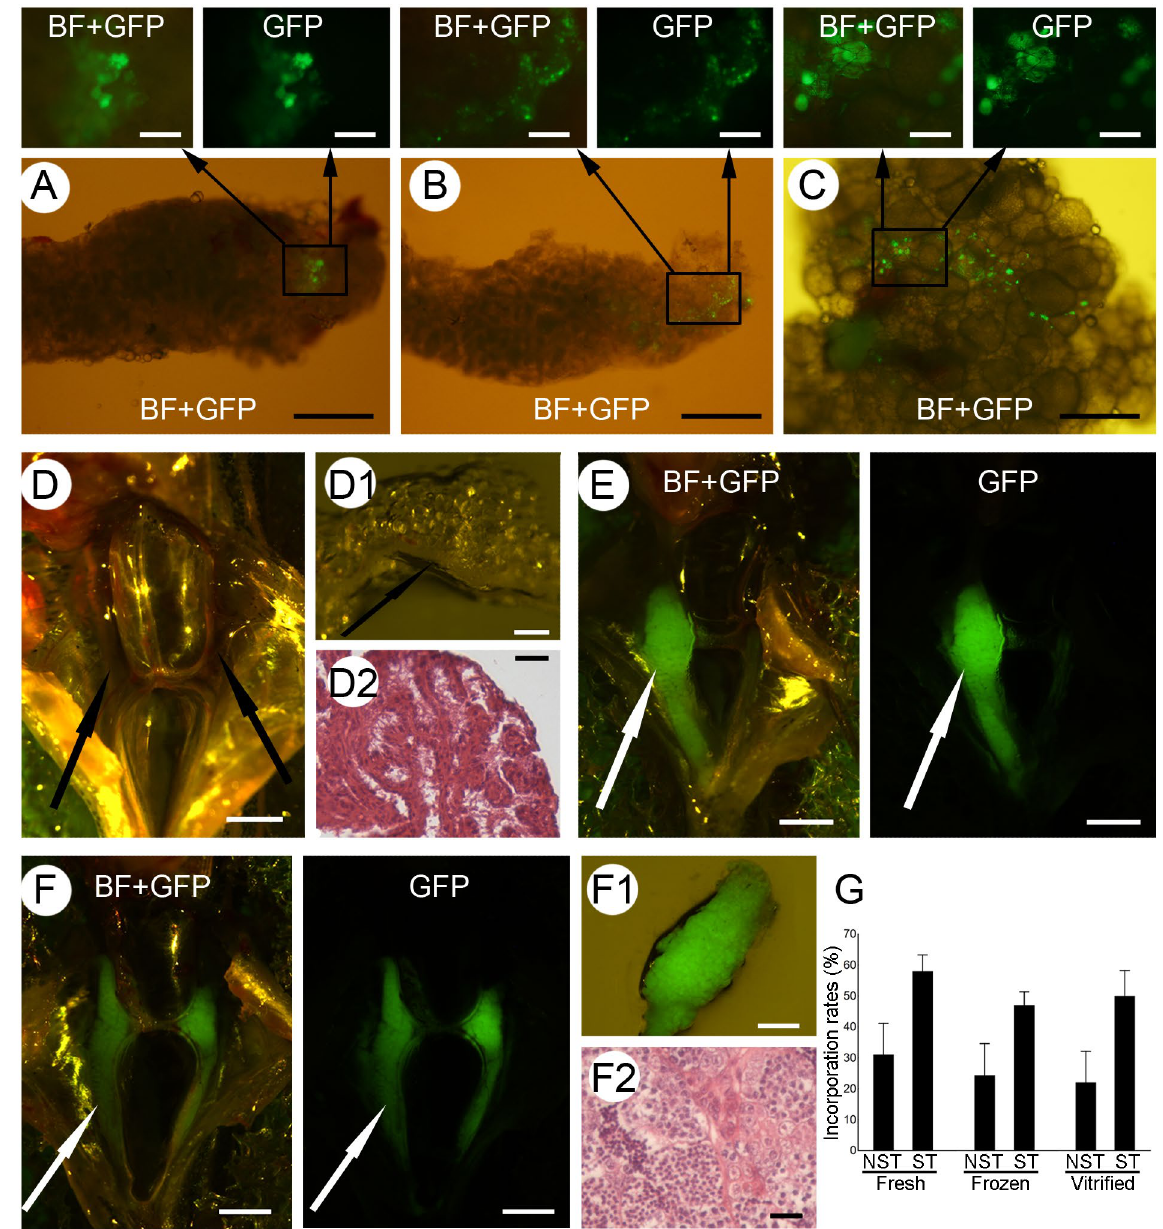
Figure 2. Incorporation and proliferation of fresh and cryopreserved spermatogonia. The incorporation and proliferation of fresh ( A ) and cryopreserved ( B , C ) vasa::egfp spermatogonia within the testes ( A , B ) and ovaries ( C ) of non-sterilized recipients. Testes (arrows) of the control MO-sterilized recipients ( D ) appear undeveloped under the stereomicroscope ( D1 ), while the histological analysis ( D2 ) displayed a lack of developing germ cells. Recipients of actb:yfp spermatogonia displayed either one ( E ) or both ( F ) developed testes (arrows). Developed testes displayed strong green fluorescence originating from donor actb:yfp spermatogonia ( F1 ), while histological analyses displayed clear differentiation of germ cells into spermatozoa ( F2 ). ( G ) Incorporation of fresh and cryopreserved spermatogonia into non-sterilized (NST) or MO-sterilized (ST) recipients. Values are presented as mean ± SD. Scale bars: (A, B, C) 500 µ m; (top panels) 100 µ m; (D, E, F) 1 mm; (D1, F1) 200 µ m; (D2, F2) 20 µ